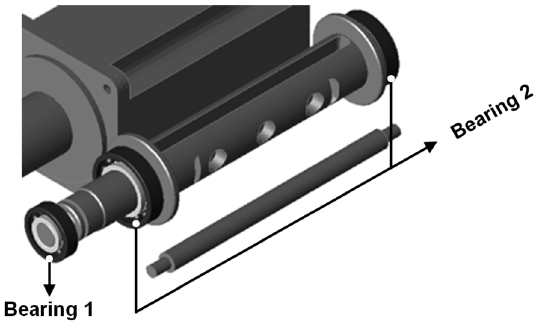
Figure 6. Detailed view of the internal structure of medical electric leg compression machine.